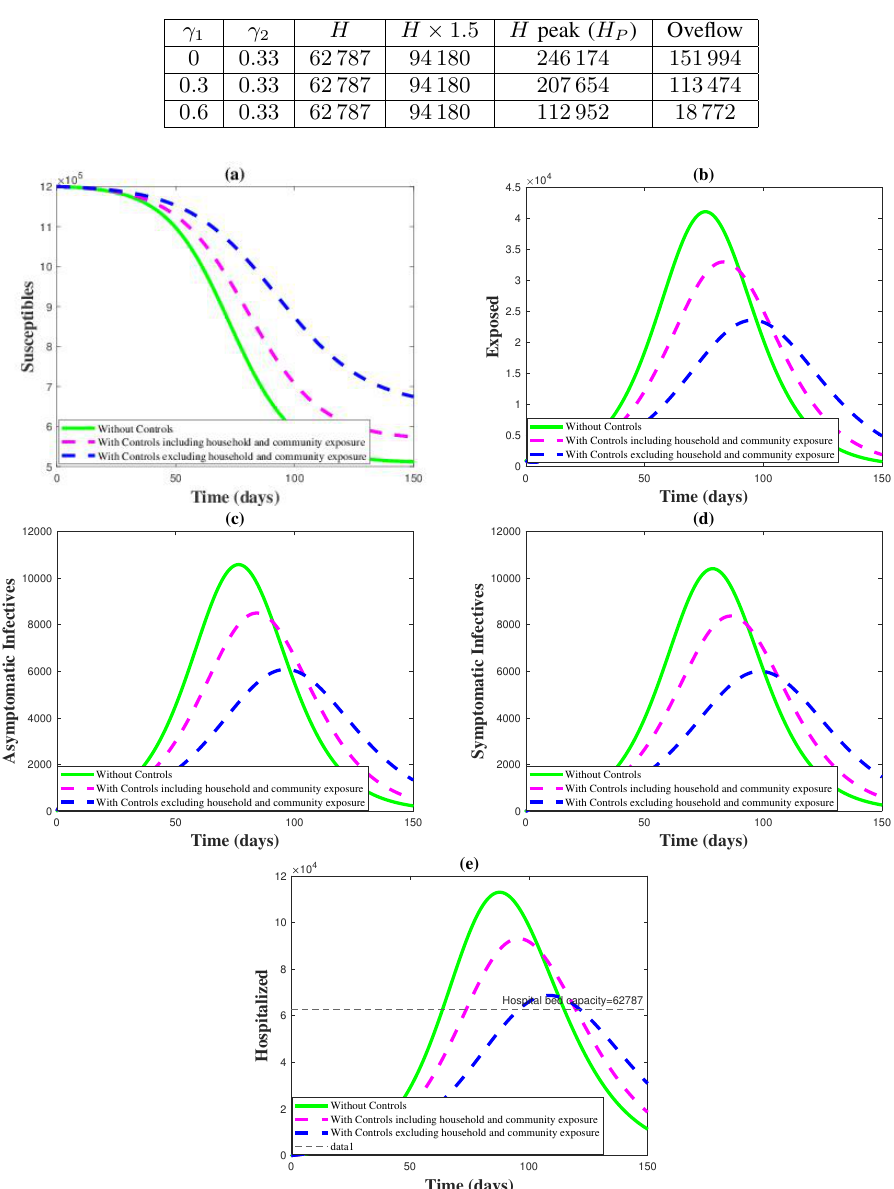
TABLE IV: Number of people who must be hospitalized.